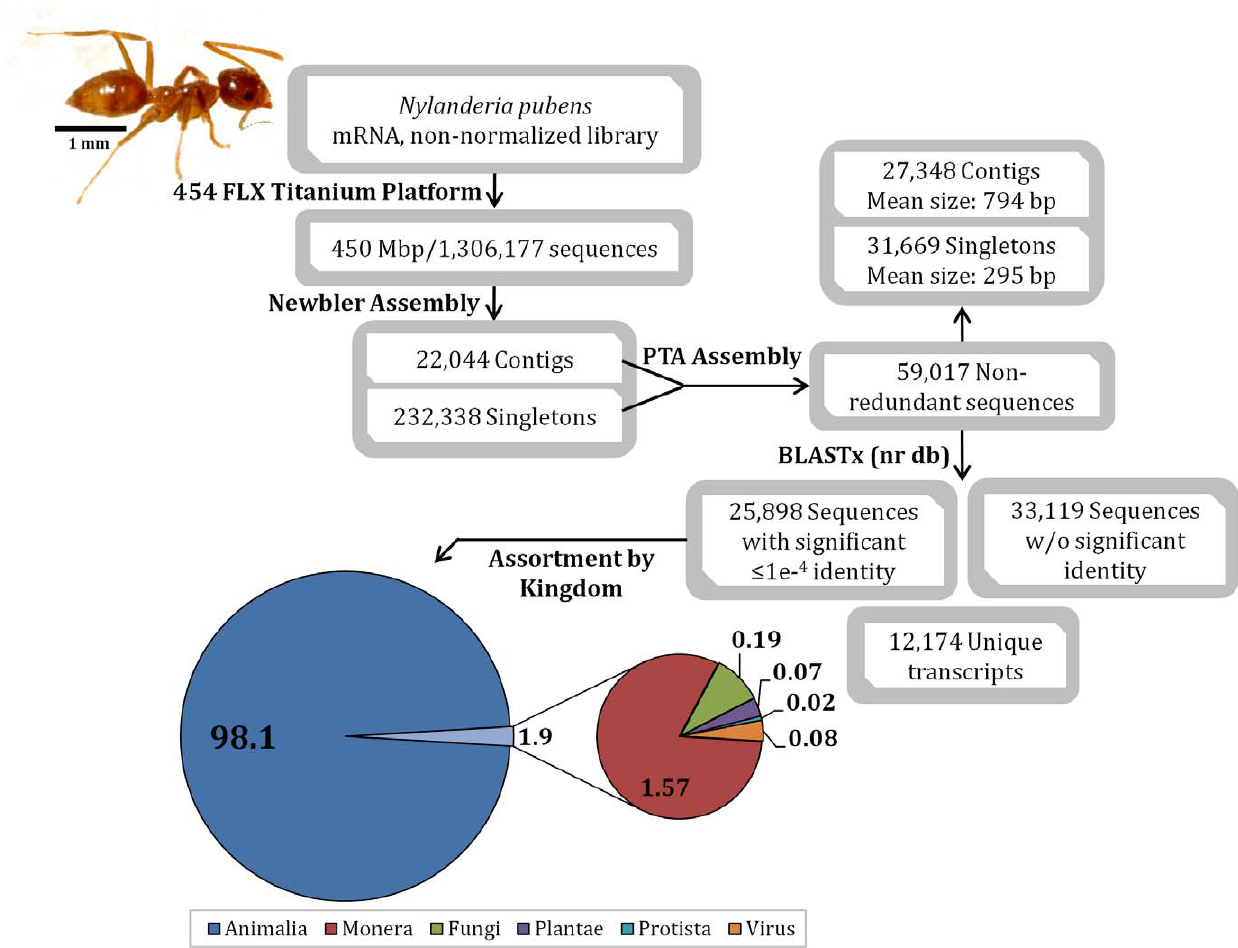
Figure 2. Diagram summarizing the work flow and results for expression library creation, sequencing, assembly and kingdom assignments for the Caribbean crazy ant, Nylanderiapubens (top left).